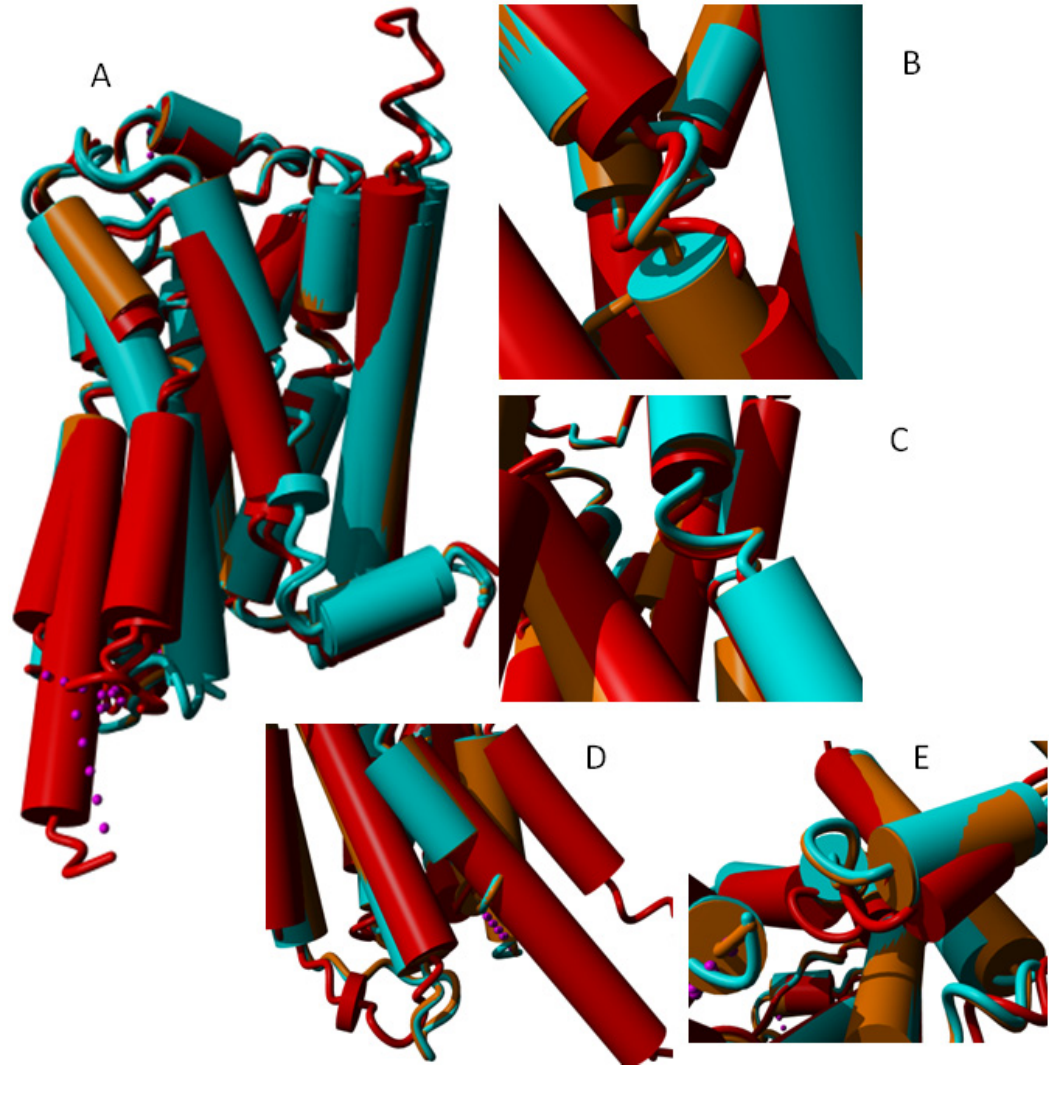
Figure 15. ( A ) Seven β 2 adrenoceptor structures superposed. Light blue: 2rh1 [56], 3d4s [57], 3ny8 [12] and 3ny9 [12] that each bind an inverse agonist; orange: 3nya